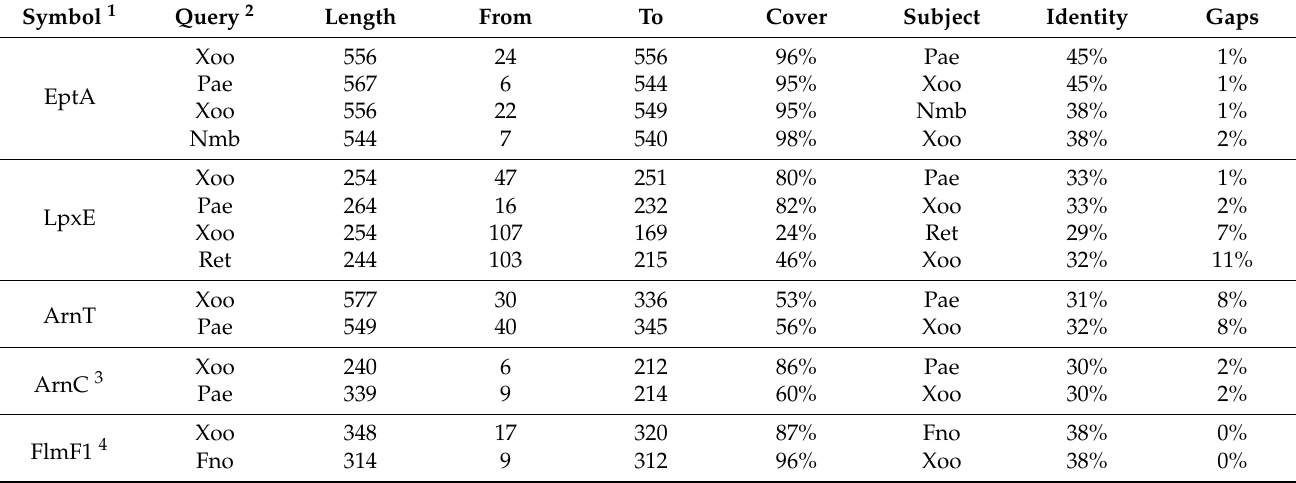
1 Locus tags and accession numbers are in Table S1. 2 Fno, Francisella novicida U112; Nmb, Neisseria meningitidis MC58; Ret, Rhizobium etli ( leguminosarum ) CFN42; Pae, Pseudomonas aeruginosa PAO1; Xoo, Xanthomonas oryzae pv. oryzae PXO99 A . 3 Xoo gene PXO_RS22265. 4 Xoo gene